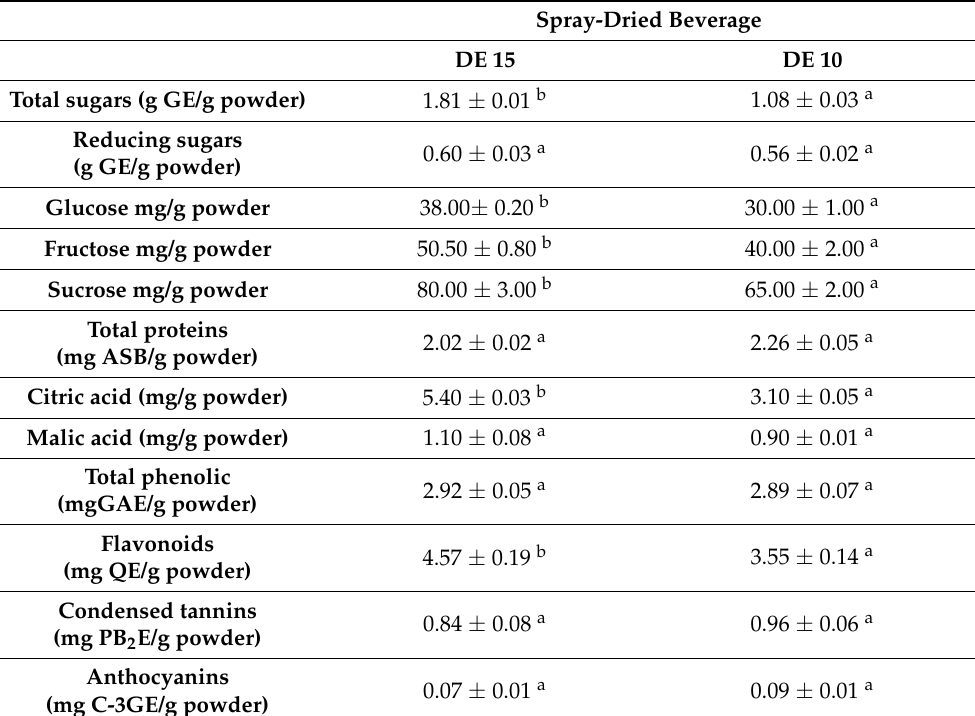
Table 2. Chemical characterization of antioxidant beverage